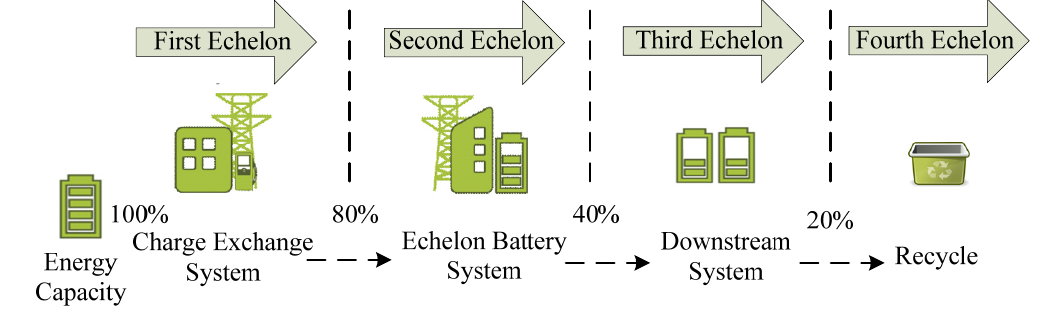
Figure 7. Echelon exploitation of